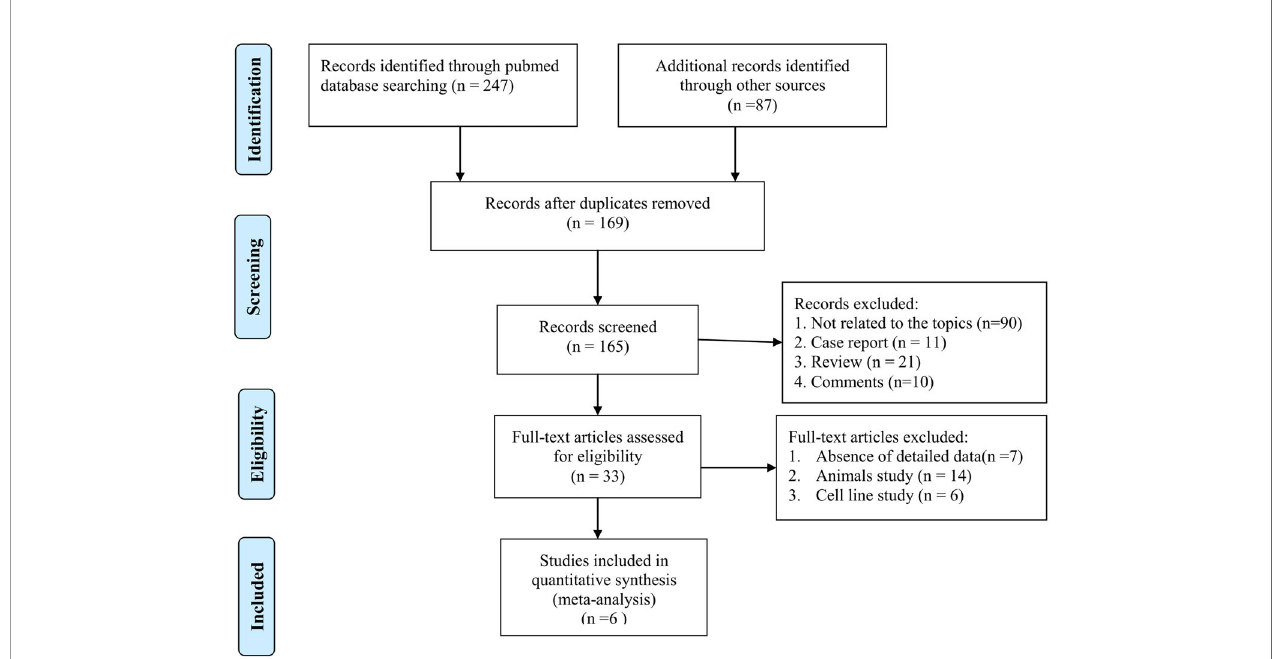
FIGURE 1 | Flowchart of studies for selecting process from